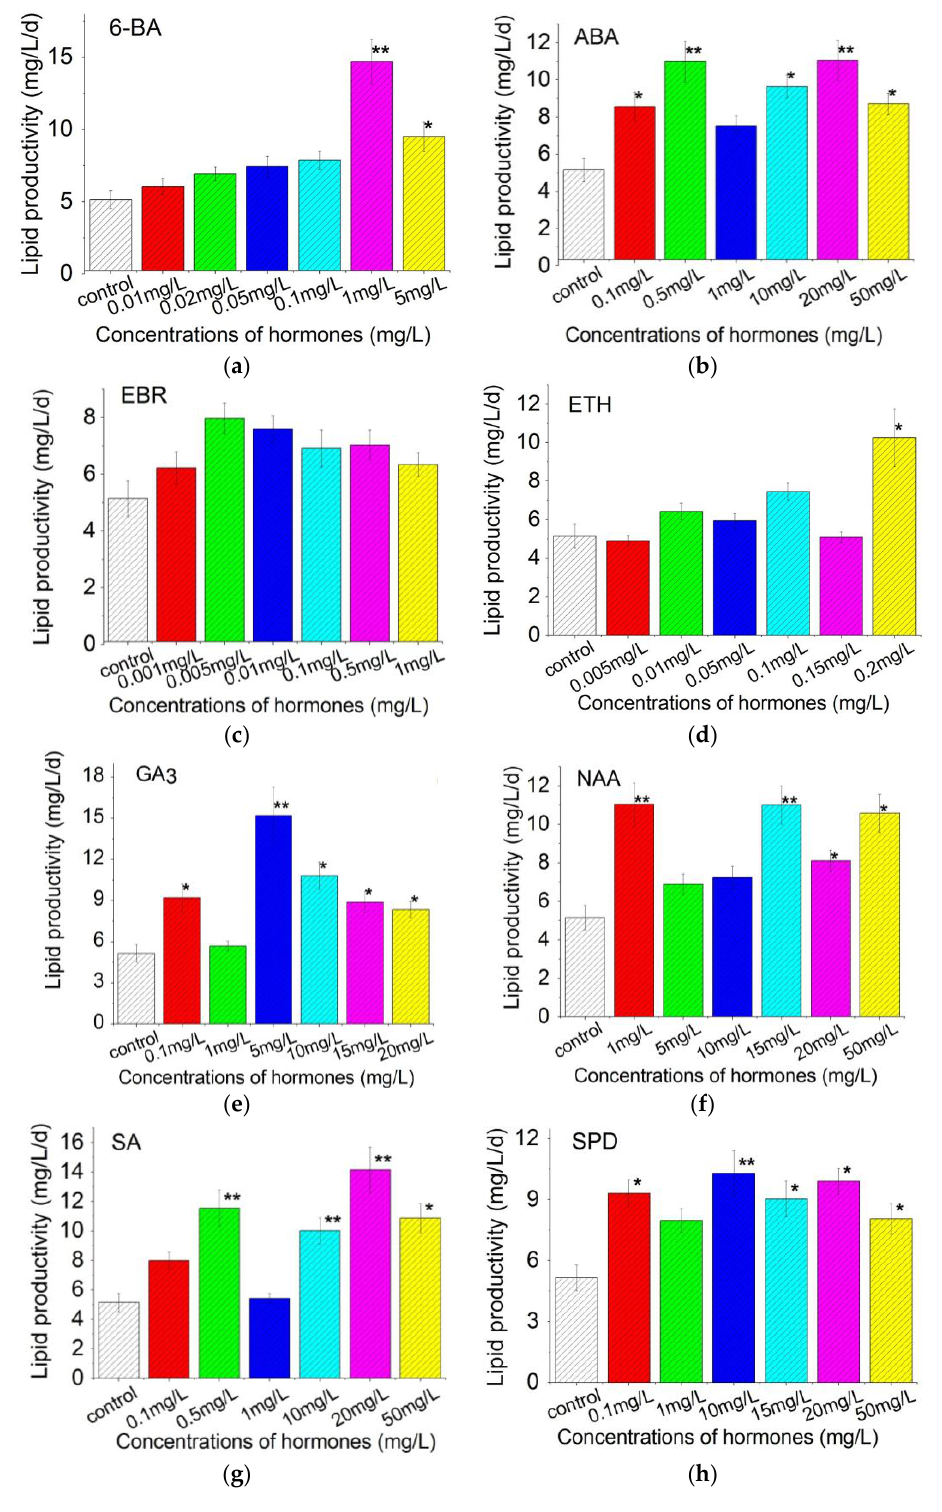
Figure 6. Lipid productivities of C. pyrenodiosa ZF strain at different concentrations of plant growth regulators: ( a ) 6-BA treatments; ( b ) ABA treatments; ( c ) EBR treatments; ( d ) ETH treatments; ( e ) GA 3 treatments; ( f ) NAA treatments; ( g ) SA treatments; ( h ) SPD treatments.